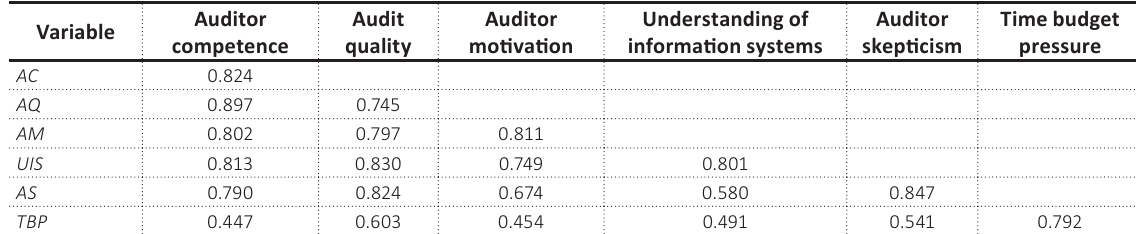
Table 6. Hypotheses testing